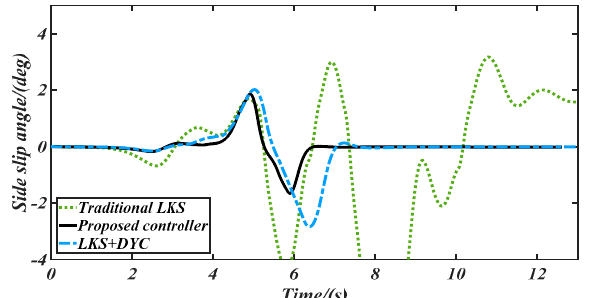
Figure 14. Vehicle sideslip angle controlled by different controllers.